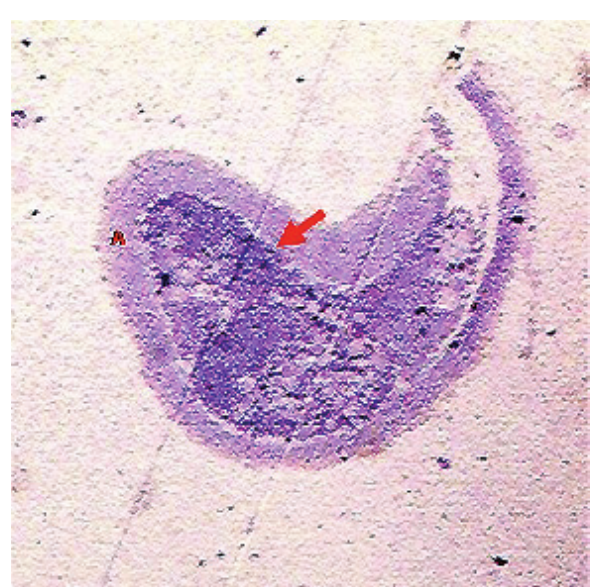
Figura 1. Embrião do grupo contaminado após o 4º dia de desenvolvimento em microscopia óptica de corte semifino (aumento de 100x). (A) Zona pelúcida. Estruturas semelhantes às da E. coli estão representadas pela